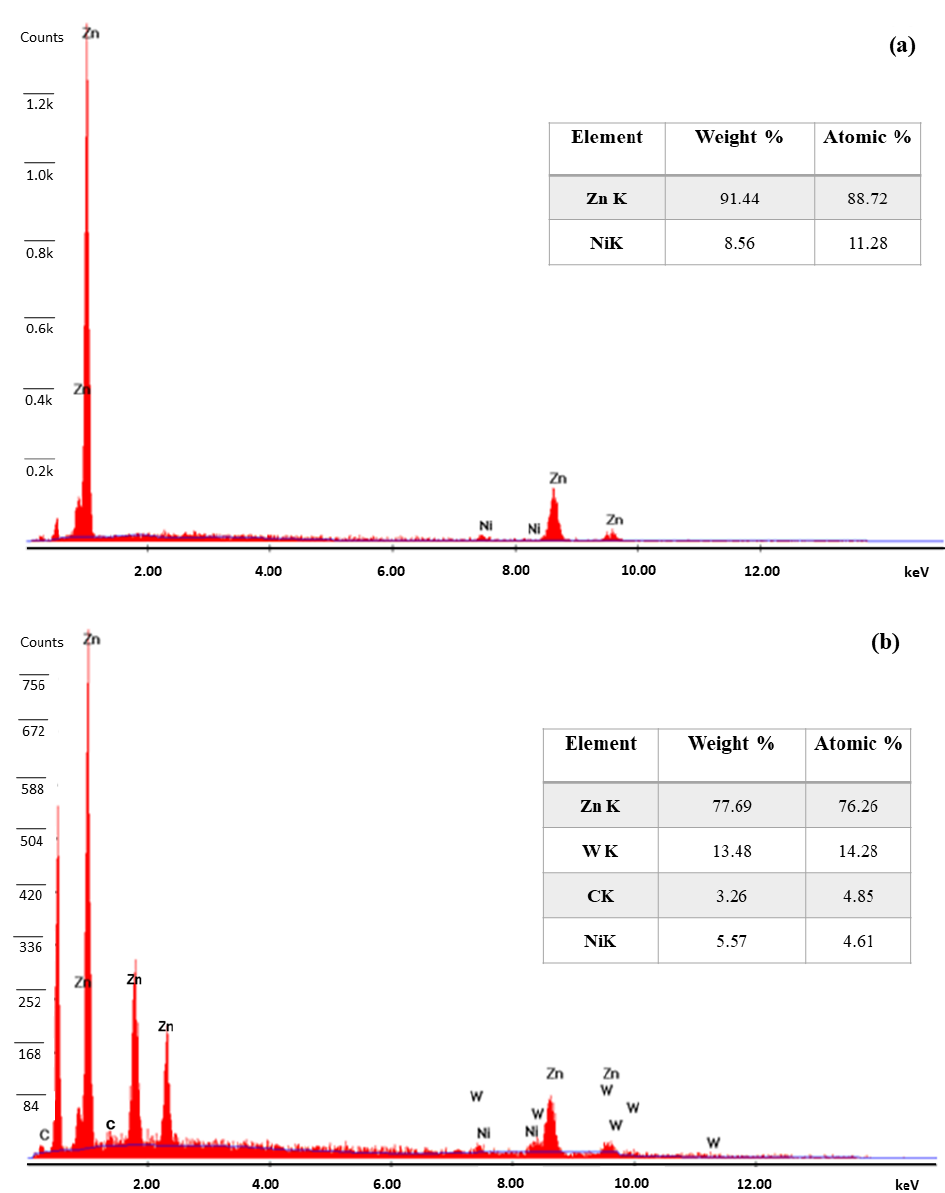
Figure 8. EDAX Patterns of coatings: ( a ) Zn–Ni alloy and ( b ) Zn–Ni–WC composites.